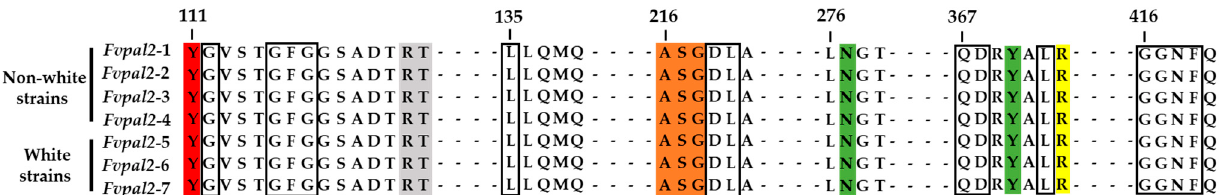
Figure 7. Alignment of the highly conserved domains of phenylalanine ammonia-lyase 2 amino acids of Flammulina velutipes strains. Red: catalytically essential tyrosine residue, orange: the MIO forming amino acid triad, green: amino acid stabilizing MIO group, yellow: arginine responsible for binding the carboxylic group of the substrate, gray: variation site of Fvpal1 gene of F. velutipes , boxes: other conserved catalytic and binding residues. F. velutipes KACC42870 (non ‐ white strain) Fvpal2 ( Fvpal2 ‐ 1), F. velutipes ASI4028 (non ‐ white strain) Fvpal2 ( Fvpal2 ‐ 2), F. velutipes ASI4049 (non ‐ white strain) Fvpal2 ( Fvpal2 ‐ 3), F. velutipes ASI4057 (non ‐ white strain) Fvpal2 ( Fvpal2 ‐ 4), F. velutipes ASI4166 (white strain) Fvpal2 ( Fvpal2 ‐ 5), F. velutipes ASI4157 (white strain) Fvpal2 ( Fvpal2 ‐ 6), F. velutipes ASI4169 (white strain) Fvpal2 ( Fvpal2 ‐ 7).